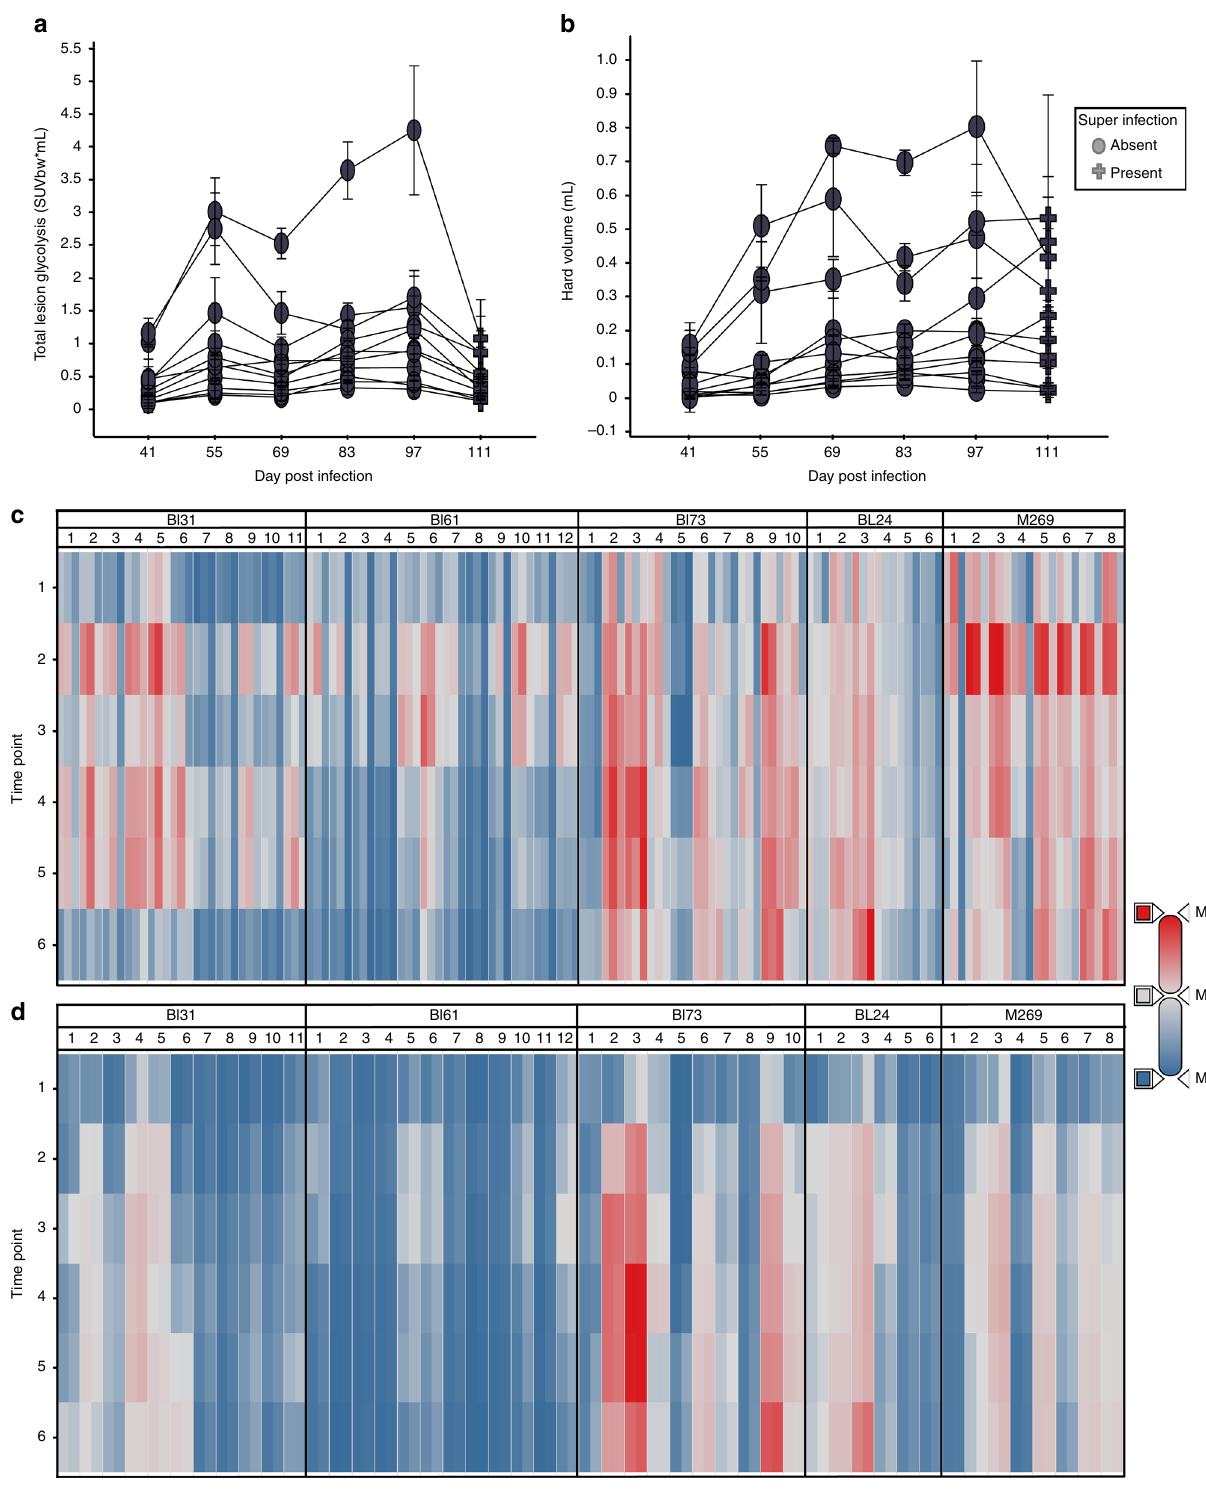
media. Apart from the expected absence of ndh and ndhA transcripts in Δ ndh-2 , we did not observe differences between the mutant and the WT (Supplementary Fig. 4E, F). To test if Δ ndh- 2 is viable due to compensation by NDH-1 we determined susceptibility of Δ ndh-2 to the NDH-1 inhibitor rotenone. Rotenone was inactive against WT Mtb , which agrees with previous data; 4 but rotenone prevented growth of and was bactericidal for Δ ndh-2 (Fig. 5a, b). We conclude that NDH-1